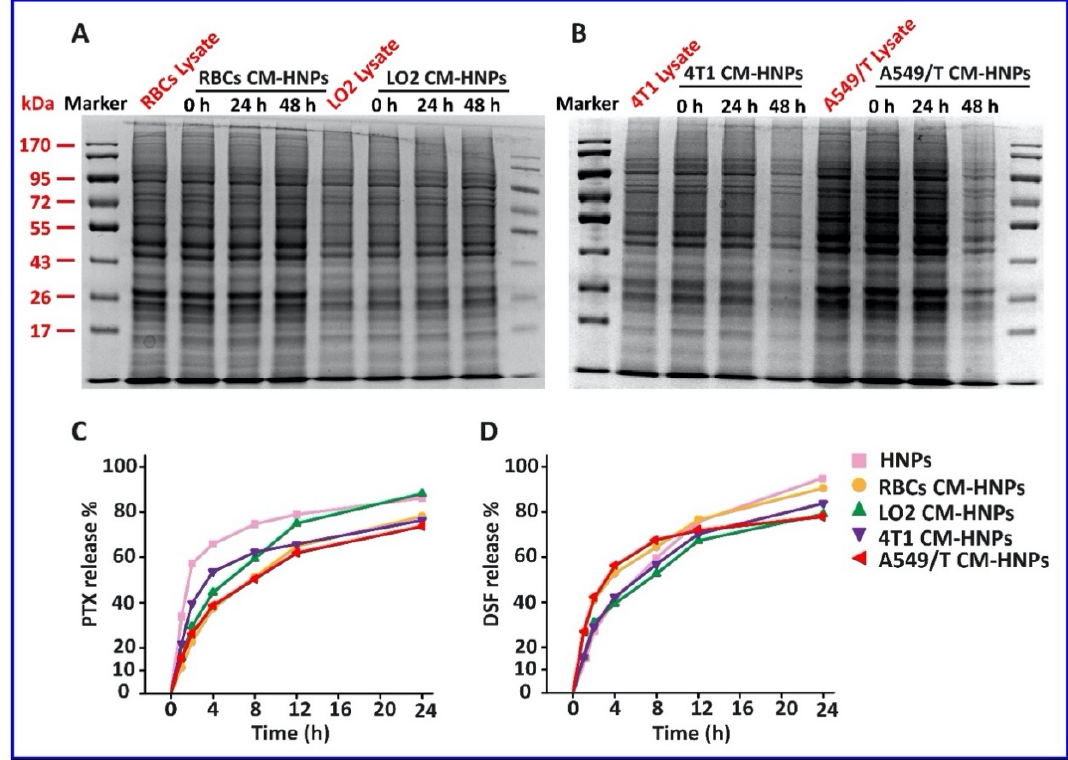
Figure 7. Membrane-associated protein translocation. ( A , B ) SDS-PAGE (Coomassie blue) assay of total membrane proteins extracted from cell membrane lysate and CM-HNPs. The in vitro release profiles of ( C ) PTX and ( D ) DSF from the nanoparticles in pH 7.4 media at 37 °C.